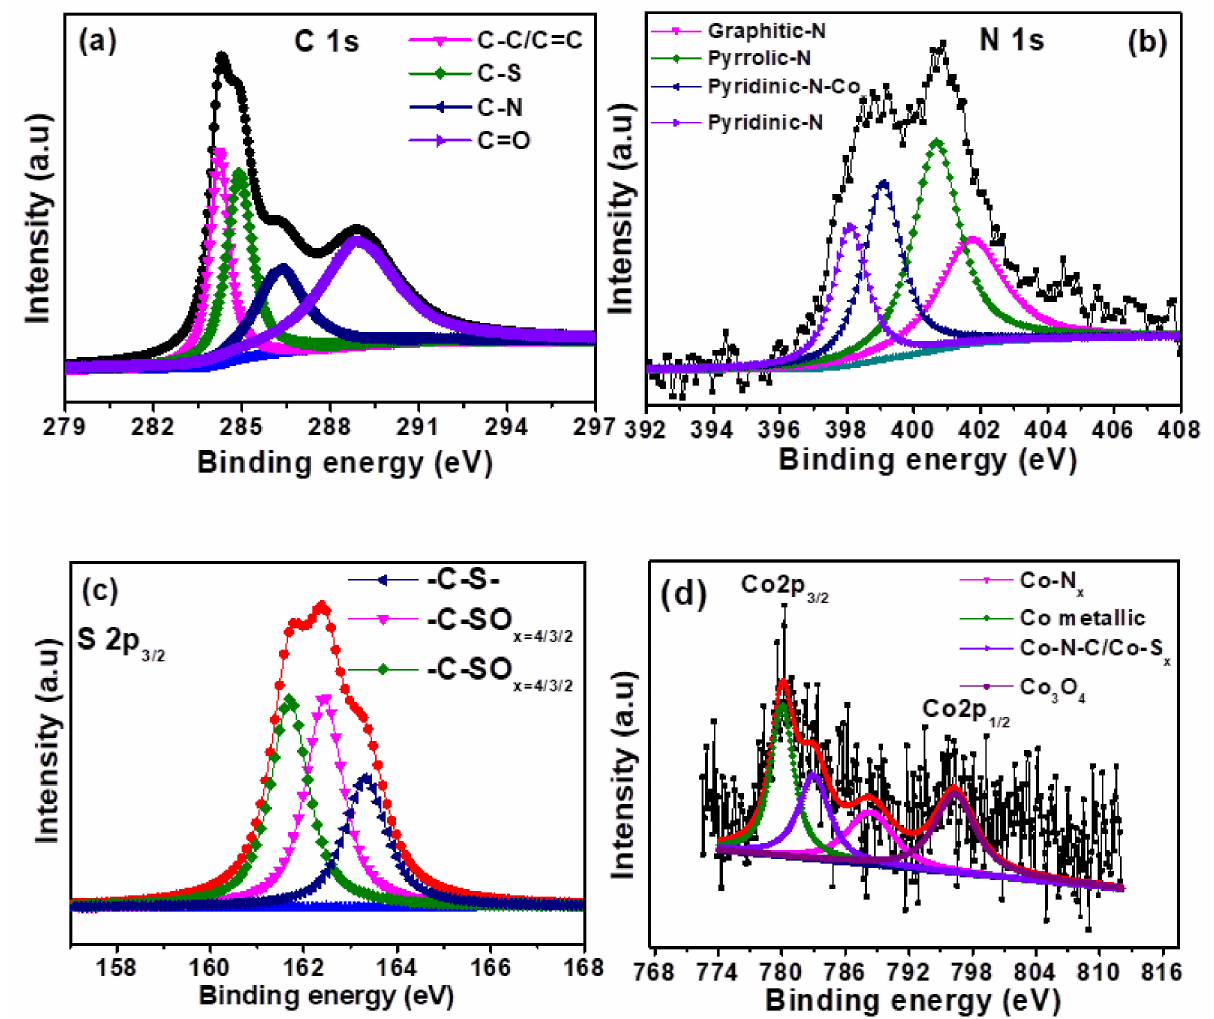
Figure 4. XPS deconvoluted spectra for ( a ) C 1 s ( b ) N 1 s ( c ) S 2p 3/2 ( d ) Co 2p